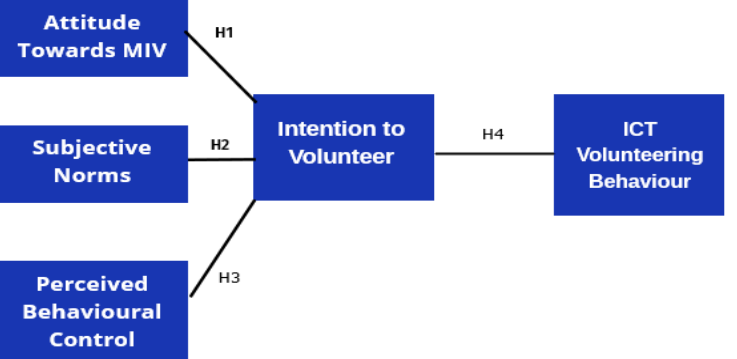
Figure 1. Research model.